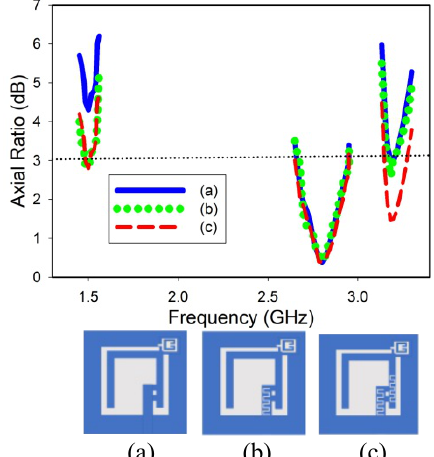
Figure 4: The effect of meandered slots on the simulated axial ratio values for the proposed